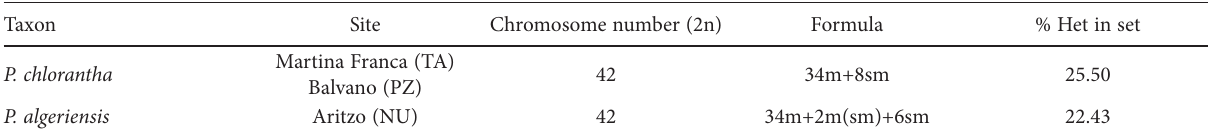
Table 1. Taxon, sites, chromosome number, formula and percent heterochromatin in set of the chromosomes of species Platanthera chlor- anta and P. algeriensis. m, metacentric; sm, submetacentric. Taxon